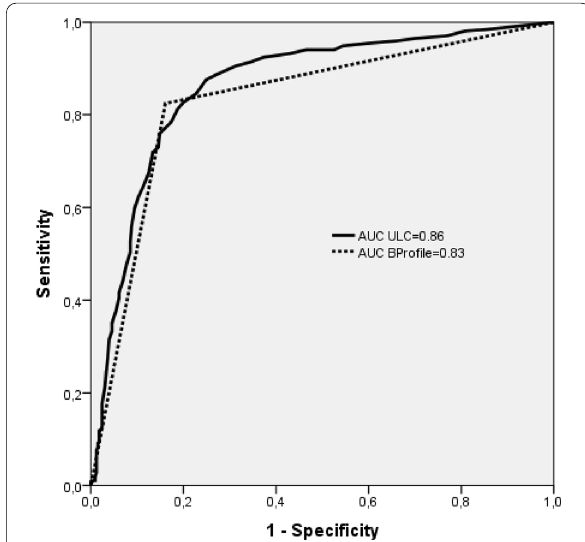
Fig. 5 Receiver operating characteristic (ROC) curve for ultrasound lung comets (ULC) score and B-profile pattern